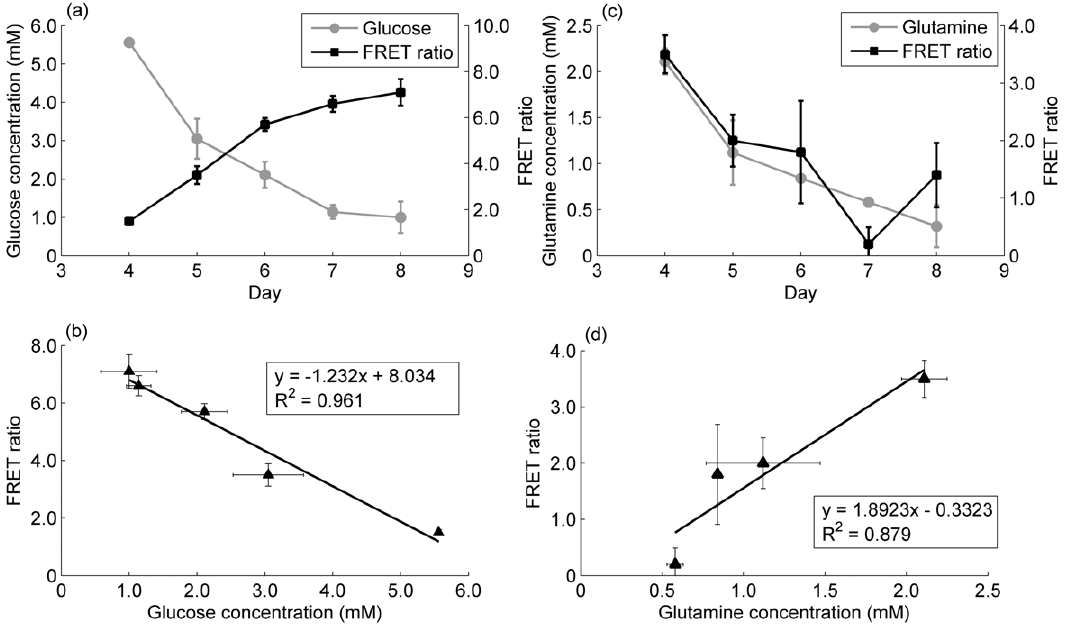
Figure 4. Invivo calibration curves. A comparison of the FRET measurements obtained from stable CHO-S cell lines constitutively expressing the biosensors and the corresponding measurements of intracellular concentrations from the same samples. a) Glucose biosensor measurements. Intracellular concentration as measured by the Amplex Red H assay (gray circles) and corresponding FRET measurements (black squares). b) FRET versus concentration calibration curve for the glucose biosensor. The line represents the linear regression best fit for the data points. c) Glutamine biosensor measurements. Intracellular concentration as measured by the coupled glutaminase glutamate dehydrogenase assay (gray circles) and corresponding FRET measurements (black squares). d) FRET versus concentration calibration curve for the glutamine biosensor. The line represents the linear regression best fit for the data points. In all cases, n=2 biological repeats with three measurements per cell line. Error bars represent one standard deviation of the